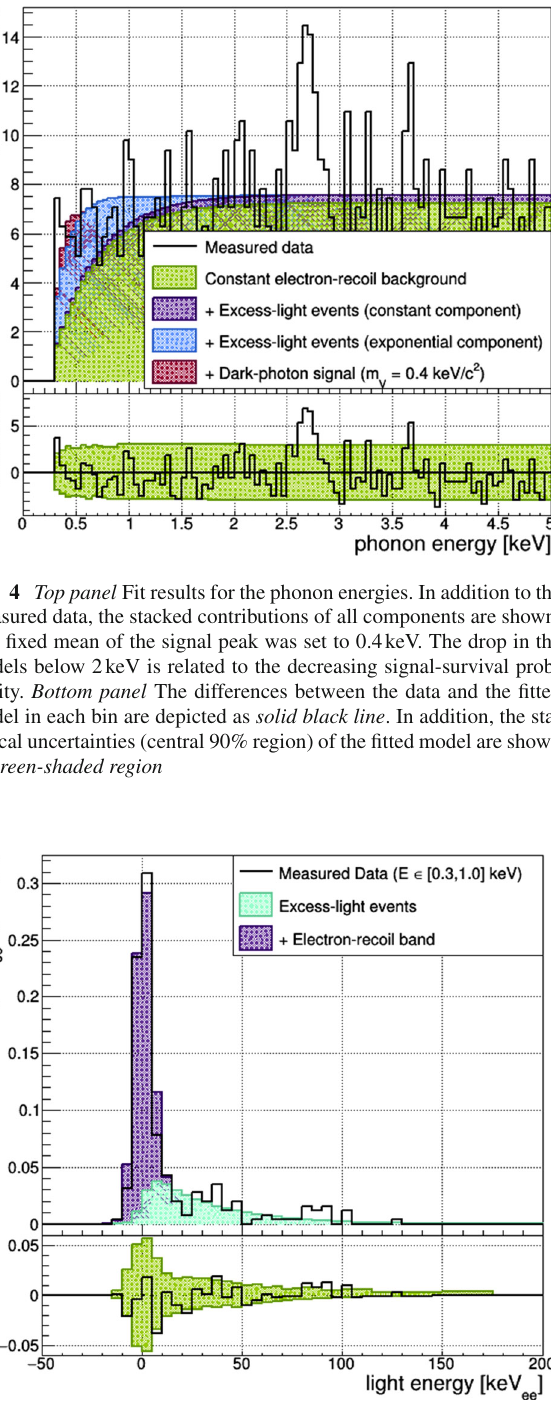
Fig. 5 Top panel Fit results for the light energies. Only events within the phonon-energy slice between 0.3 and 1keV are shown in this plot. In addition to the measured data, the stacked contributions from the electron-recoil band and excess-light events are shown. Bottom panel The differences between the data and the fitted model are depicted as solid black line . In addition, the statistical uncertainties (central 90% region) of the fitted model are shown as green-shaded